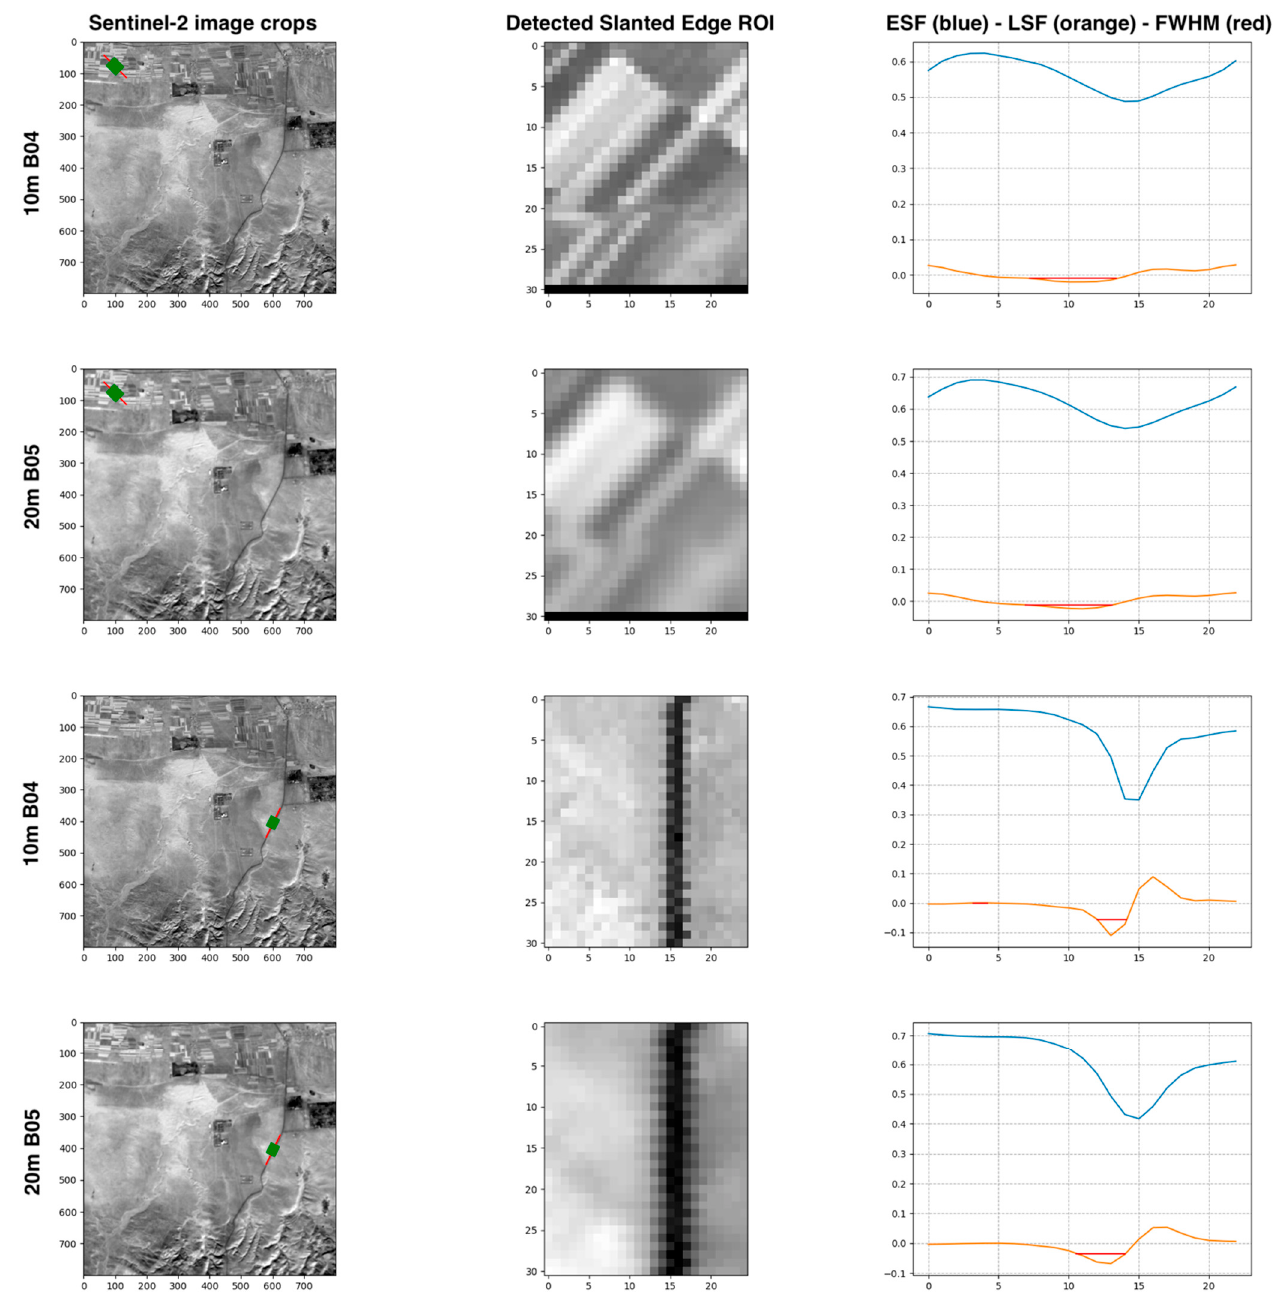
Figure 5. Examples of the Exp-1 ELF measurements for two detected slanted edge ROIs of a 8𝑘𝑚 × 8𝑘𝑚 image crop at Site-1. 1 st column: Sentinel-2 image crops of the 10m/pixel B04 band and 20m/pixel B05 band images (pre-upsampled to 10m/pixel for comparison) showing two examples of the detected slanted edges in the green box; 2 nd column: zoom-in views of the examplar slanted edges within the automatically extracted ROIs; 3 rd column: plots of ESFs (blue curve), LSFs (orange curve) and FWHMs (red line) for the examplar slanted edges. For all Exp-1 ELF measurements of all detected slanted edges within the 8𝑘𝑚 × 8𝑘𝑚 image crop at Site-1, please refer to supplementary material. N.B. Units of the x and y axes of the 1 st column and the 2 nd column, and x axes of the 3 rd column figures are “pixels”; units of the y axes of the 3 rd column figures are normalised intensity values – [0, 1] for ESF and [ − 0.1, 0.1] for LSF. 1 st and 2 nd columns show images at different sizes of 8𝑘𝑚 × 8𝑘𝑚 and 250𝑚 × 300𝑚 , respectively.